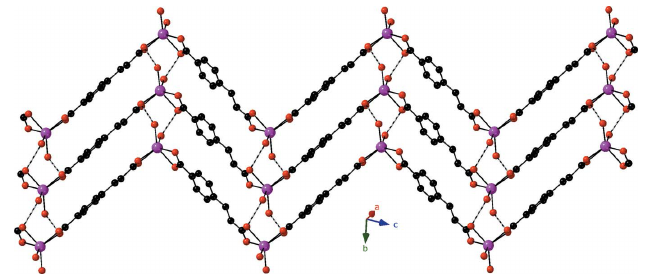
Figure 3 Supramolecular layer in the title compound, oriented parallel (101). The O—H (cid:2)(cid:2)(cid:2) O hydrogen-bonding interactions between adjacent chain submotifs are shown as dashed lines